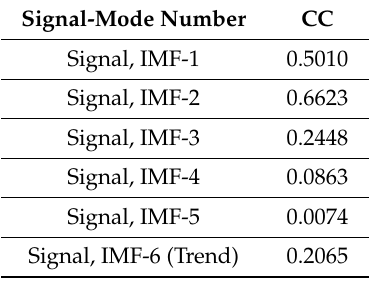
Table 4. Correlation Coefficient (CC) values of the El Niño Modoki index and its